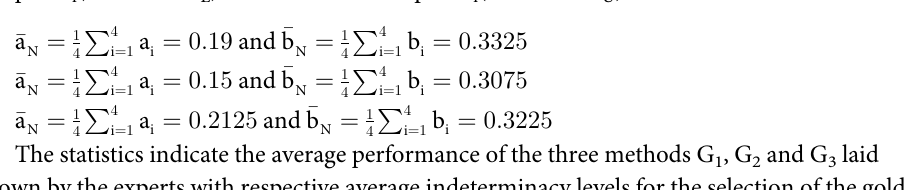
The proposed test using the real data for three centers G mented as follows Step-1: Select a neutrosophic random sample of size n part a (i = 1,2, . . . ,n ) and indeterminate part b i L